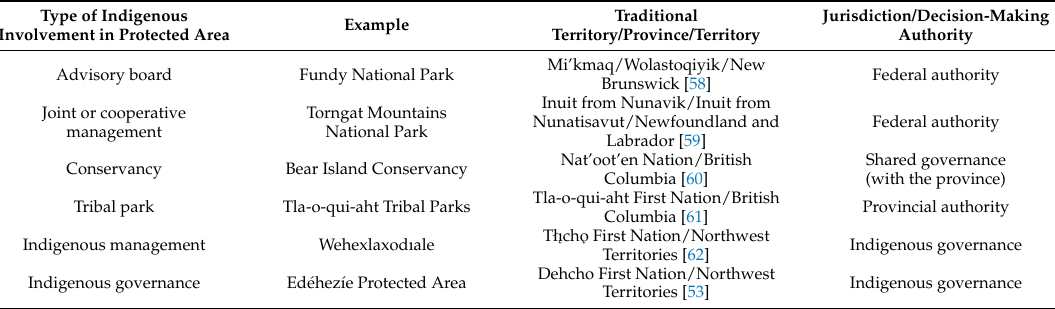
Table 1. Indigenous involvement in protected areas management in Canada. Models adapted from We Rise Together by the ICE